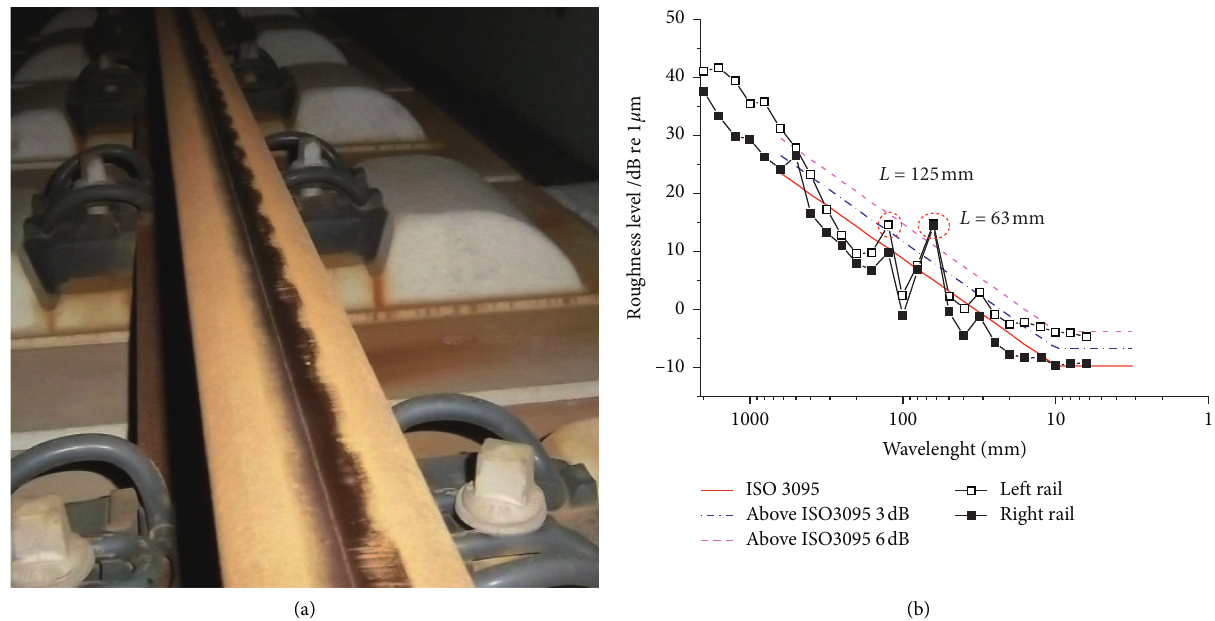
Figure 1: Picture and roughness spectra of rail corrugation in Section A.